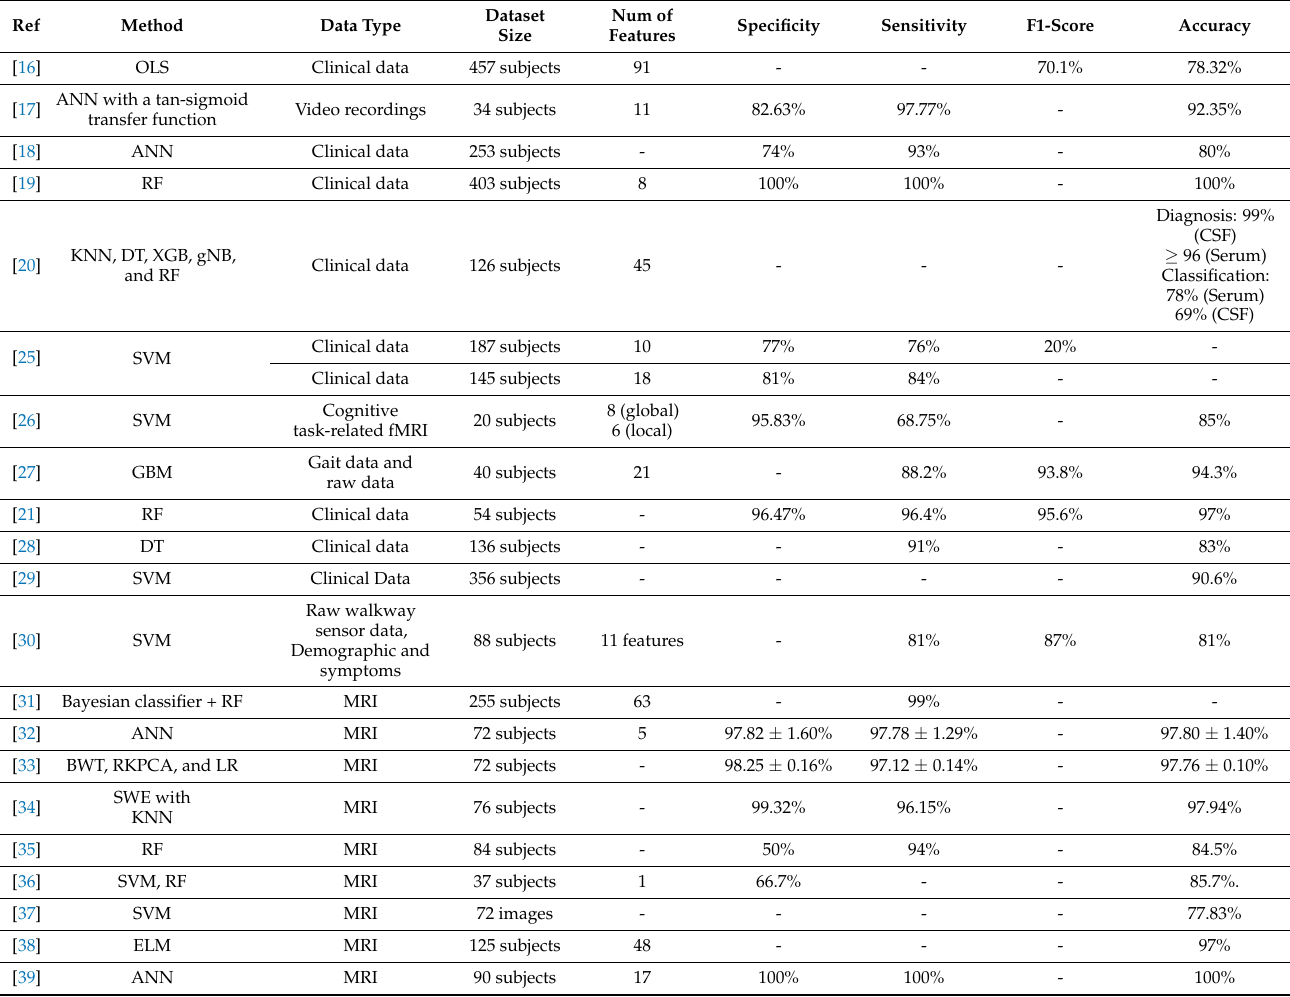
Table 1. Summary of related studies using machine